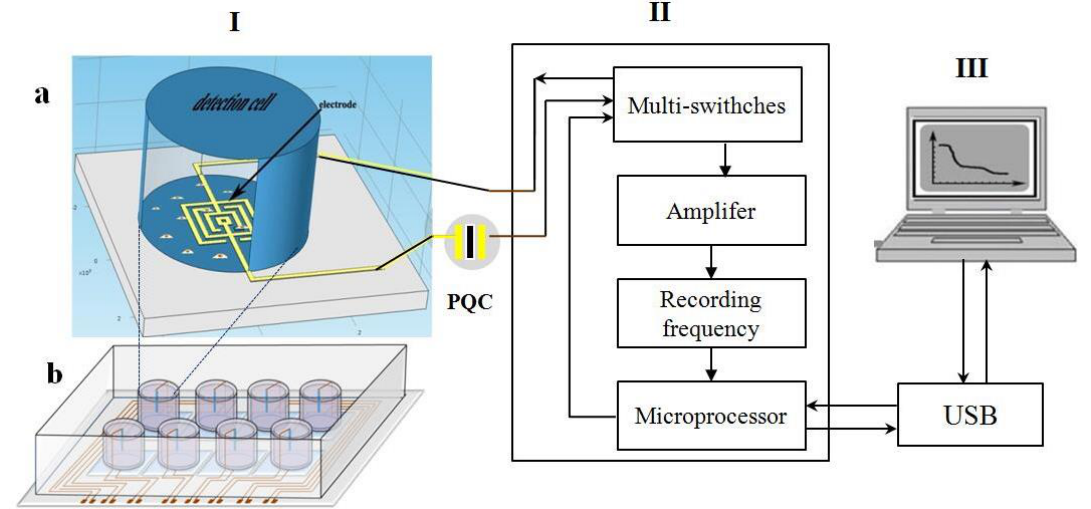
Figure 1. Schematic diagram of the piezoelectric biosensor connected serially with microelectrode. I: ( a ) culture-detection well; ( b ) a detection plate containing 8 detection wells; II: frequency meter and data processing system; III: PC interface; PQC: 9 MHz AT-cut piezoelectric quartz crystal.